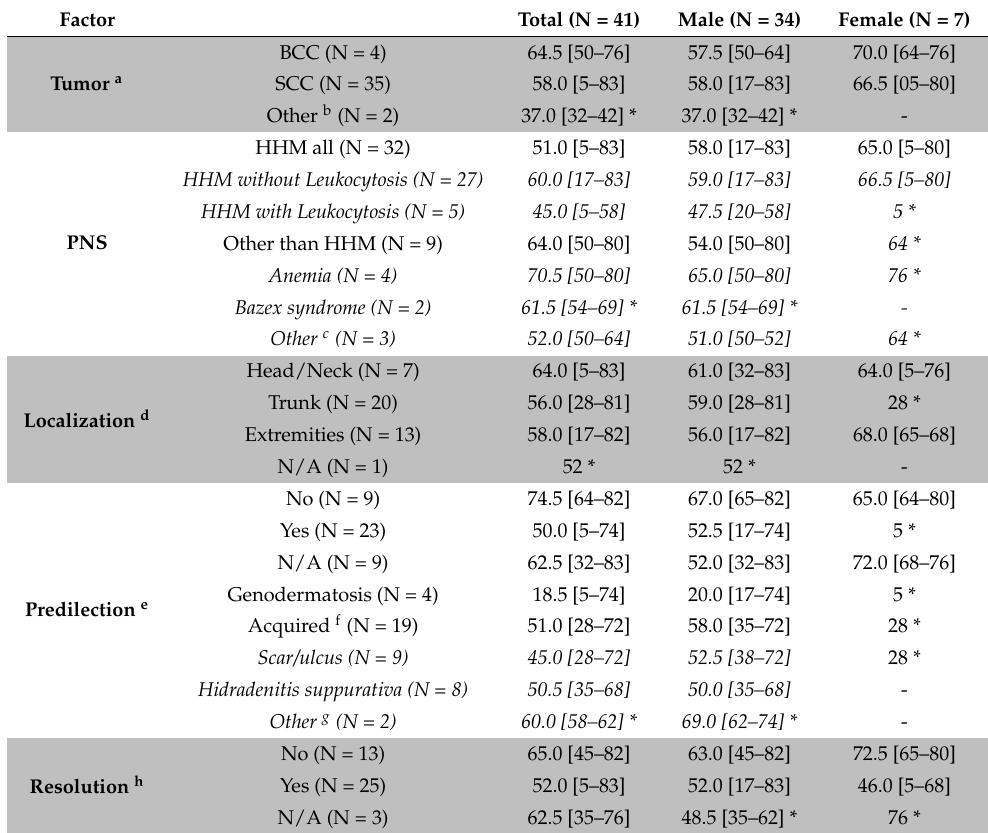
Table 4. Age of patients (Median [Range]) at the time of diagnosis of a keratinocyte skin cancer associated paraneoplastic syndrome, stratified according to patients’